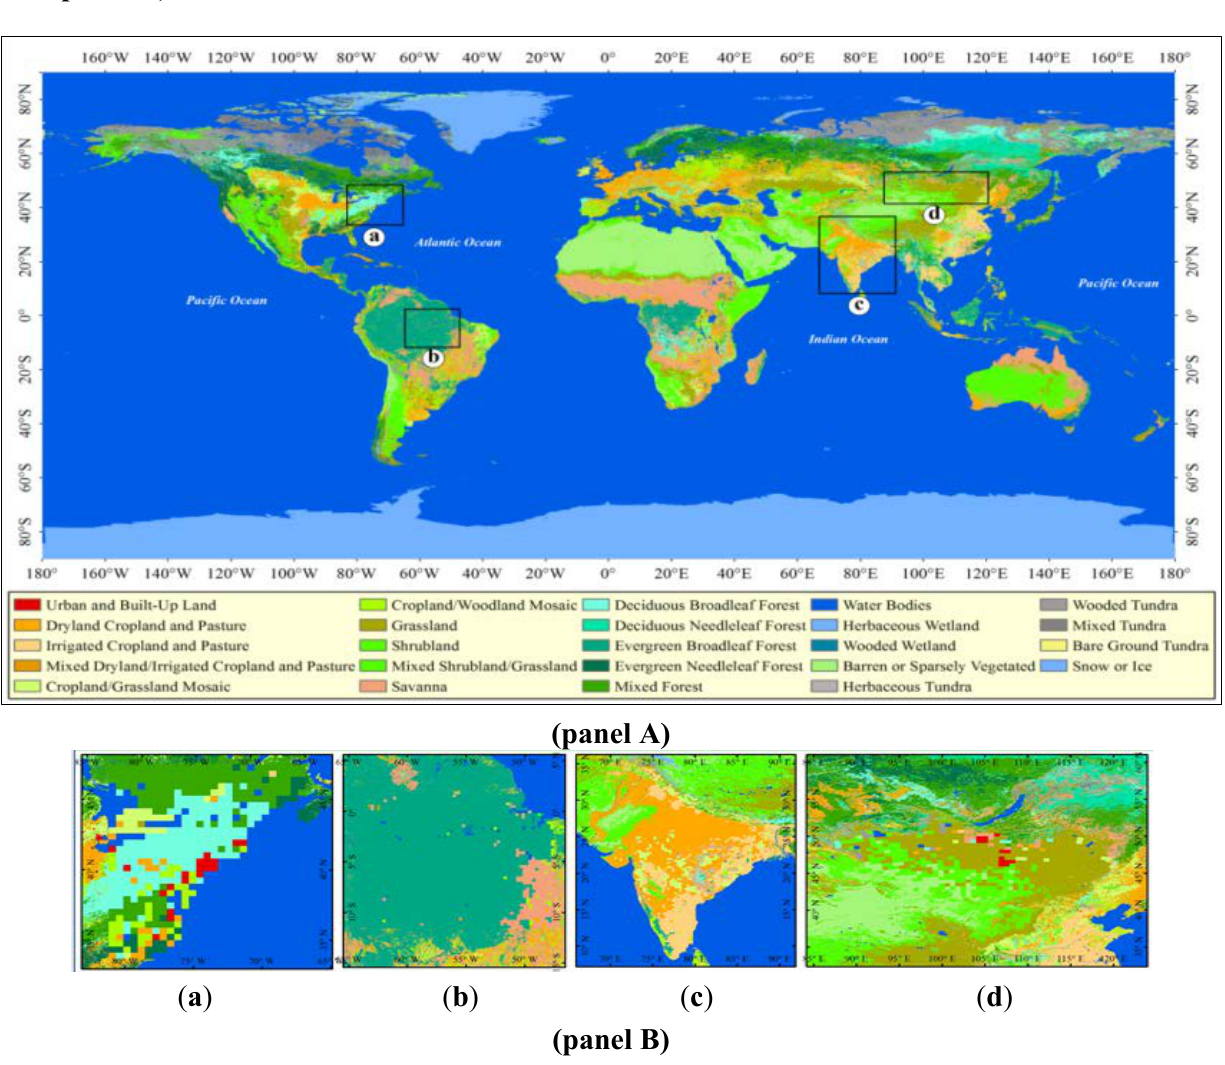
Figure 1. Distribution of the study areas ( panel A ) and their land use/cover (magnified in panel B ) in